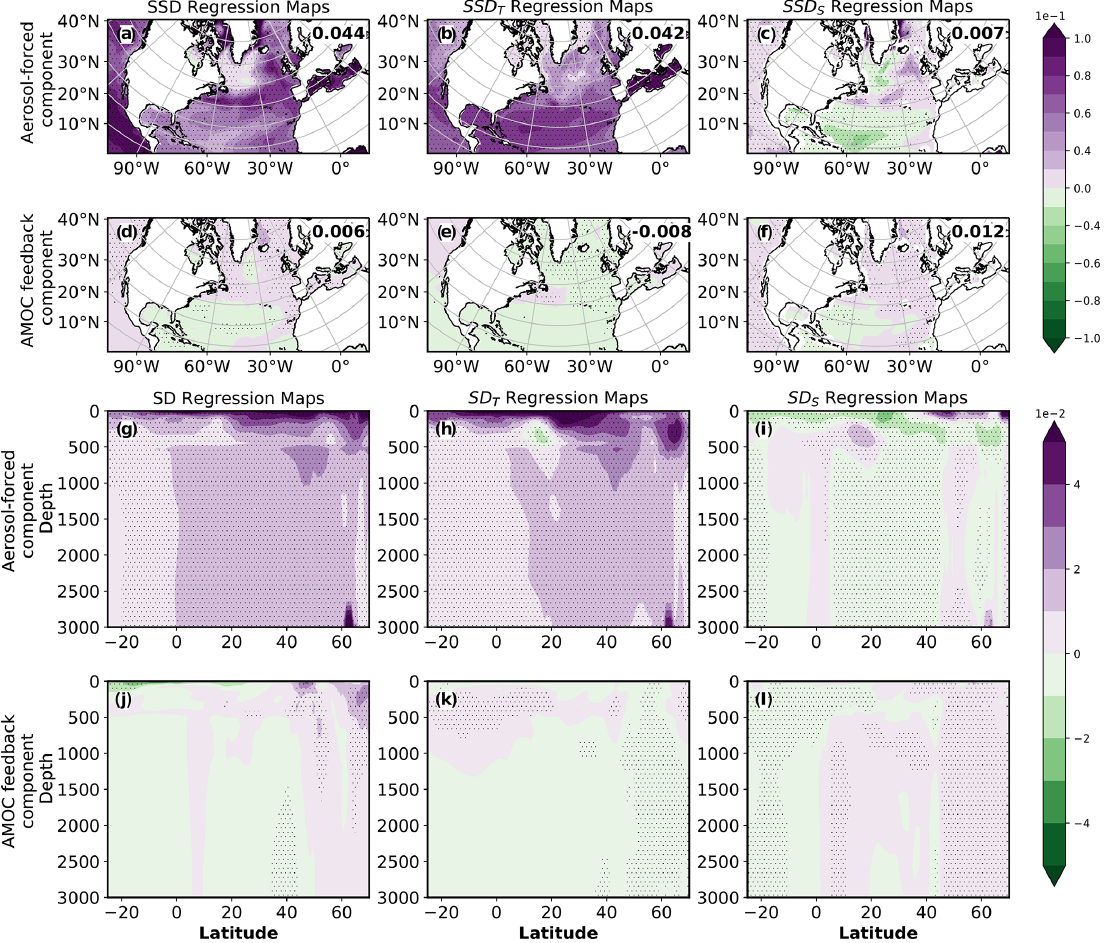
Figure 7. The 1940–2020 ensemble mean annual mean CMIP6 all forcing regression analysis: decomposition of (a, d) sea surface density (SSD), (b, e) thermal component of SSD (SSD T ), (c, f) haline component of SSD (SSD S ), (g, j) zonal mean Atlantic seawater density (SD), (h, k) thermal component of SD (SD T ), and (i, l) haline component of SD (SD S ) into (a–c, g–i) aerosol-forced and (d–f, j–l) AMOC feedback components. The forced response is obtained by regressing the subpolar North Atlantic − 1 · SW time series (a proxy for anthropogenic aerosols) onto each field. The AMOC-related feedback is obtained by removing the variability associated with the forced response, and then regressing the AMOC time series onto this new field. The feedback field is converted to the same units as the aerosol-forced field by multiplying the feedback field by the regression slope between the AMOC and − 1 · SW subpolar North Atlantic time series δ( AMOC ) 0 . 32Sv ( Wm − 2 ) − 1 , significant at the 95% confidence level. Numbers in the top right of each panel show the subpolar North Atlantic averaged regression coefficients (in units of kgm − 3 /Wm − 2 ). The units for all SSD regression maps are kgm − 3 /Wm − 2 . Symbols denote regression significance at the 95% confidence level. For the SD analysis (g–l) , a subset of six CMIP6 all models are used: